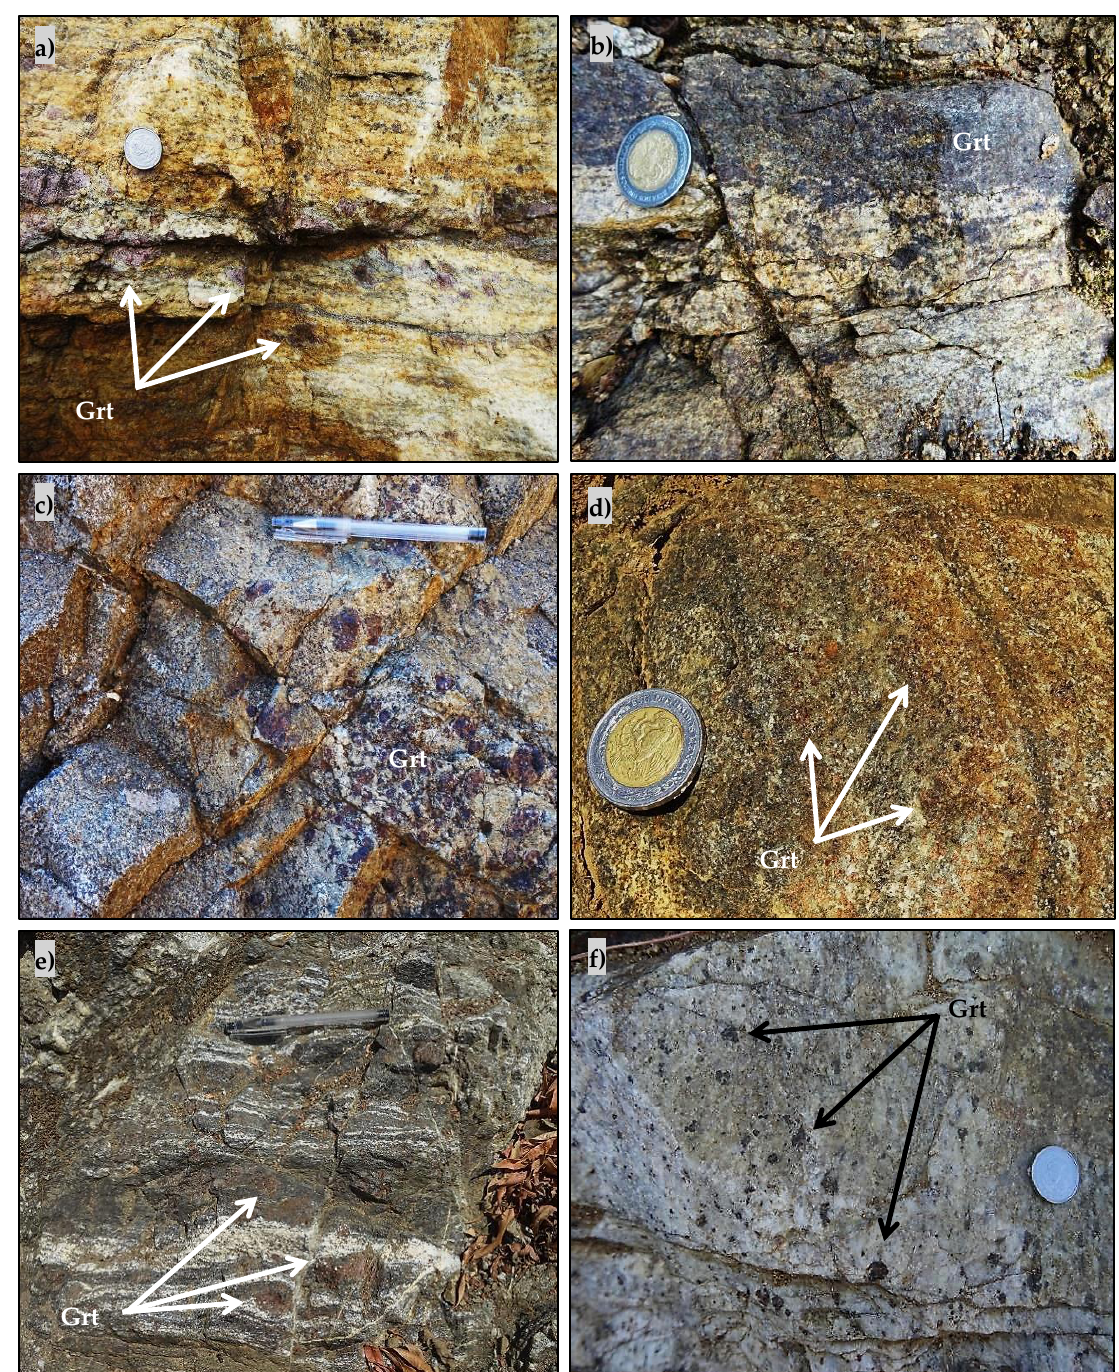
Figure 3. ( a ) Grt outcrop with augen gneiss textures from Qz-Fsp paragneiss. ( b ) Outcrop of centimetric to millimetric Grt size levels, which constitute a garnetite from Qz-Fsp paragneiss. ( c ) Outcrop of orthogneiss lithotype that holds up to 60% Grt constituting a garnetite. ( d ) Outcrop of centimetric to millimetric size Grt from basic orthogneiss. ( e ) Outcrop with centimetric Grt porphyroblasts from migmatite. ( f ) Outcrop with millimetric and centimetric Grt porphyroblasts from quartzite. The size of the scale markers: pen = 13.5 cm and coin 2.5 cm.